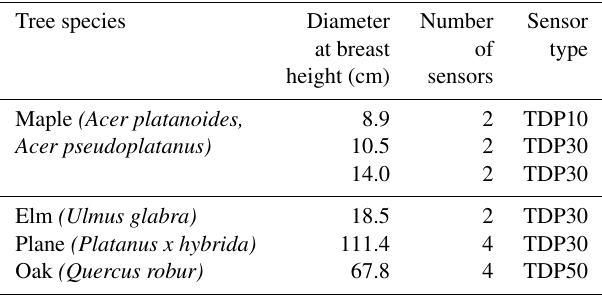
Table 2. Characteristics of trees and sensors of the sap flow instal-